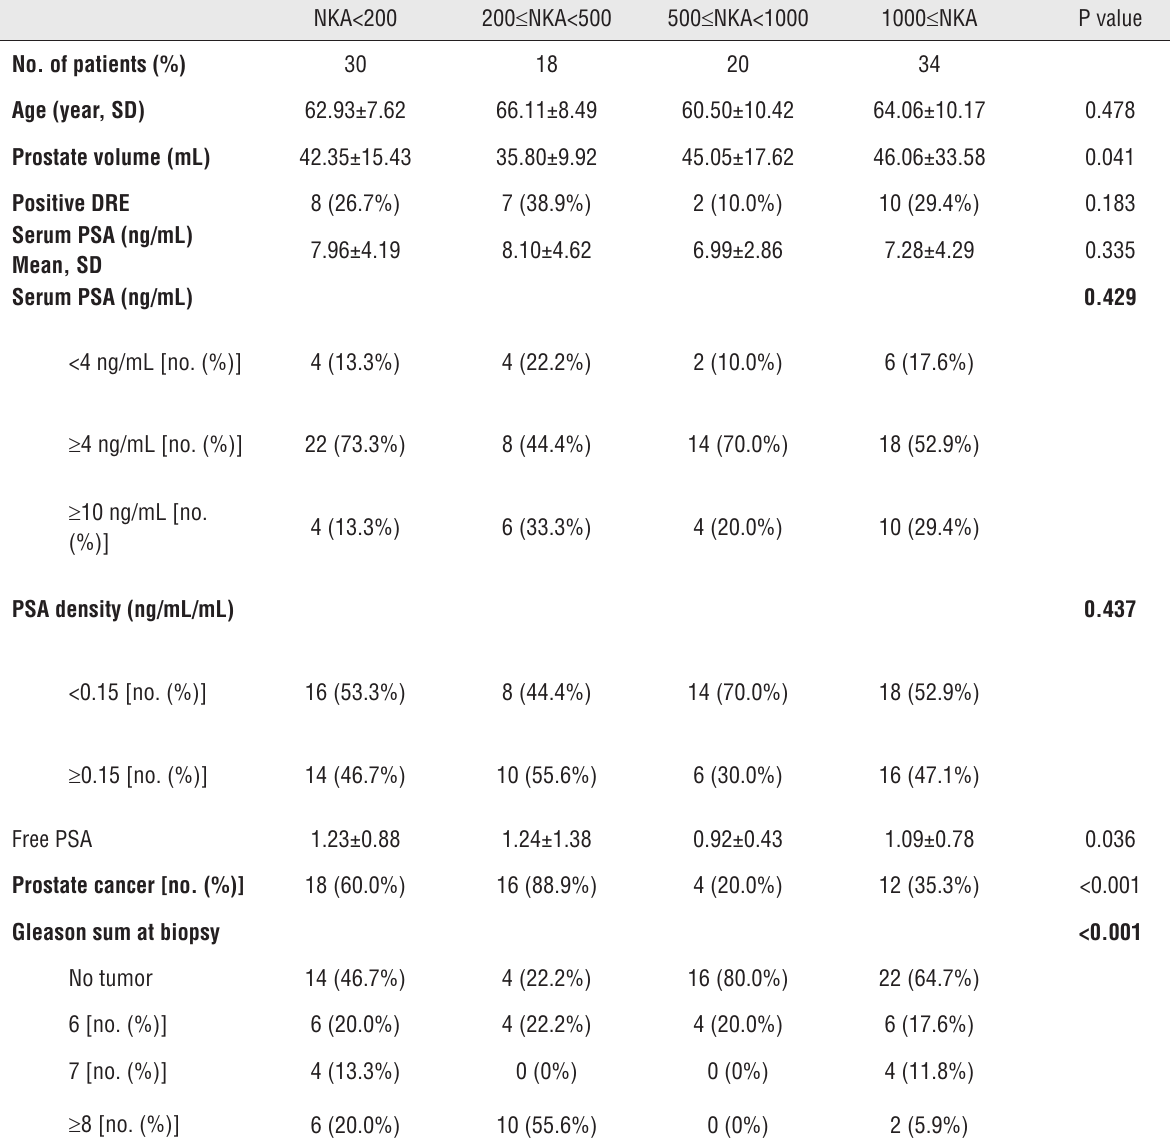
Table 2 - Baseline characteristics according to NKA (n =